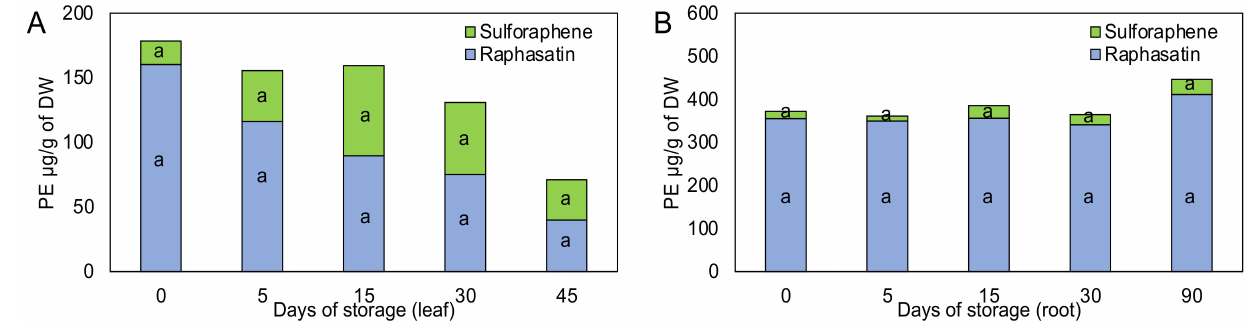
Figure 2. Glucosinolate hydrolysis product concentration (phenyl isothiocyanate equivalent, PE) changes in detached leaf ( A ) and topped radish root ( B ) during 1 ◦ C cold postharvest storage. Mean is expressed as from triplicates (n = 3). Different letters indicate significant difference across different days of storage within the same compound at p = 0.05 by Tukey’s test.